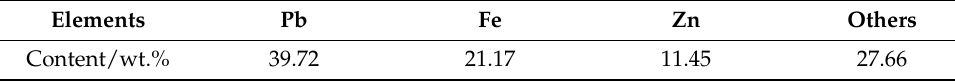
Figure 10. XRD pattern of leaching residue and zinc hypoxide. At the same time, combined with chemical composition analysis, the content of ZnFe 2 O 4 was 42.45% and the content of PbCO 3 was 51.23%, so it is very important to achieve the removal of PbCO 3 . Table 5. Element content in ammonia leaching residue.